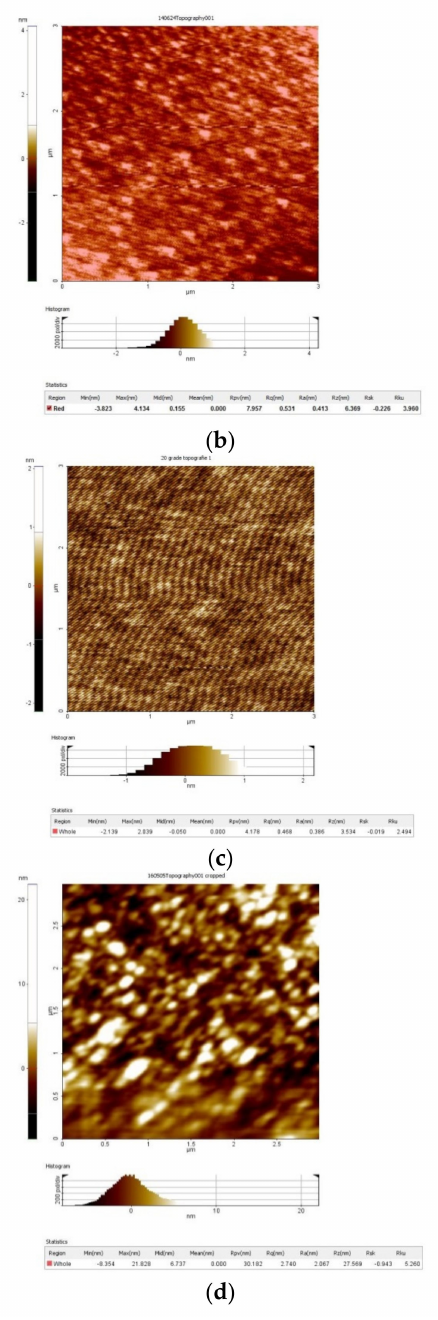
Figure 26. AFM-2D surface images of thin films samples (roughness parameters) ( a ) TiO 2 /Si; ( b ) TiN/Si; ( c ) NbN/Si; ( d ) Au/Cr/SiO 2